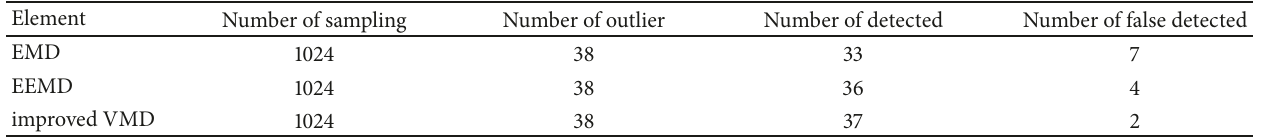
Table 1: Detection results of abnormal data.